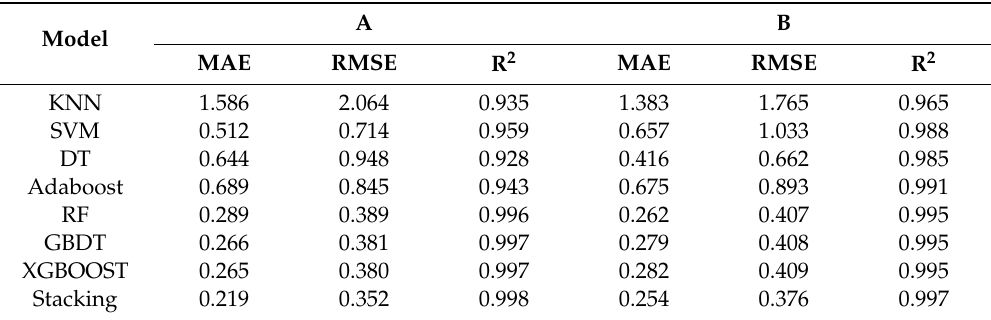
Table 4. Performance of the models.